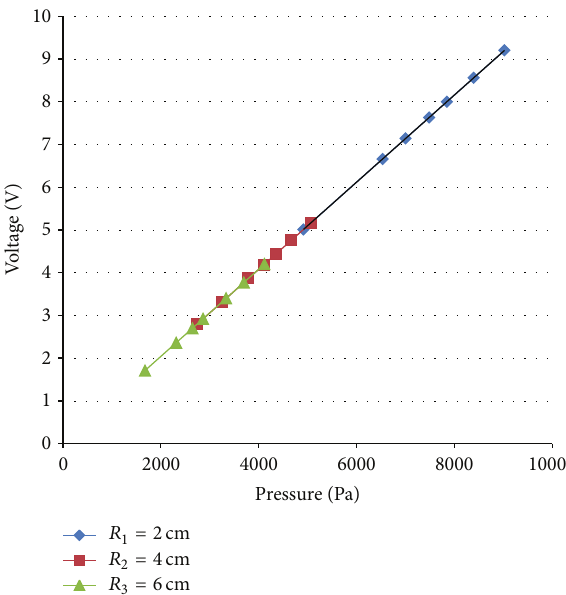
Figure 14: Output voltages from the PZT sensor versus pressure on sensor.